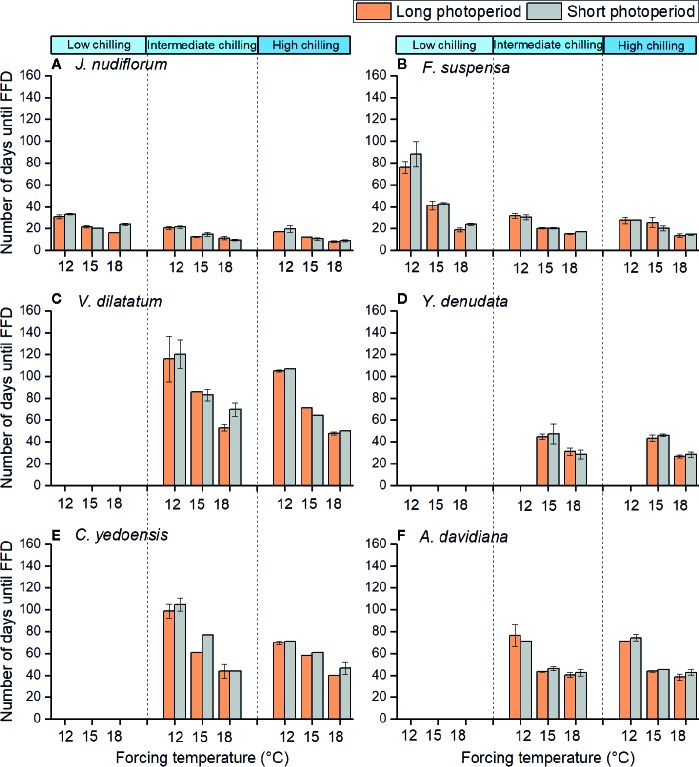
Number of days from sampling dates to the first flowering date of six species at different chilling, forcing temperature and photoperiod conditions. The low (3 chilling days), intermediate (38 chilling days), and high (59 chilling days) indicate different chilling treatments, respectively. 12, 15, and 18°C indicate different forcing temperatures. Different colors indicate long (14h) and short (10 h) photoperiods. The flowers of the last four species could not open in low chilling condition. The error bars indicate standard deviation among three replicates (no error bar is presented when the standard deviation equals to zero). (A)
J. nudiflorum, (B)
F. suspensa, (C)
V. dilatatum, (D)
Y. denudata, (E)
C. yedoensis, (F)
A. davidiana.